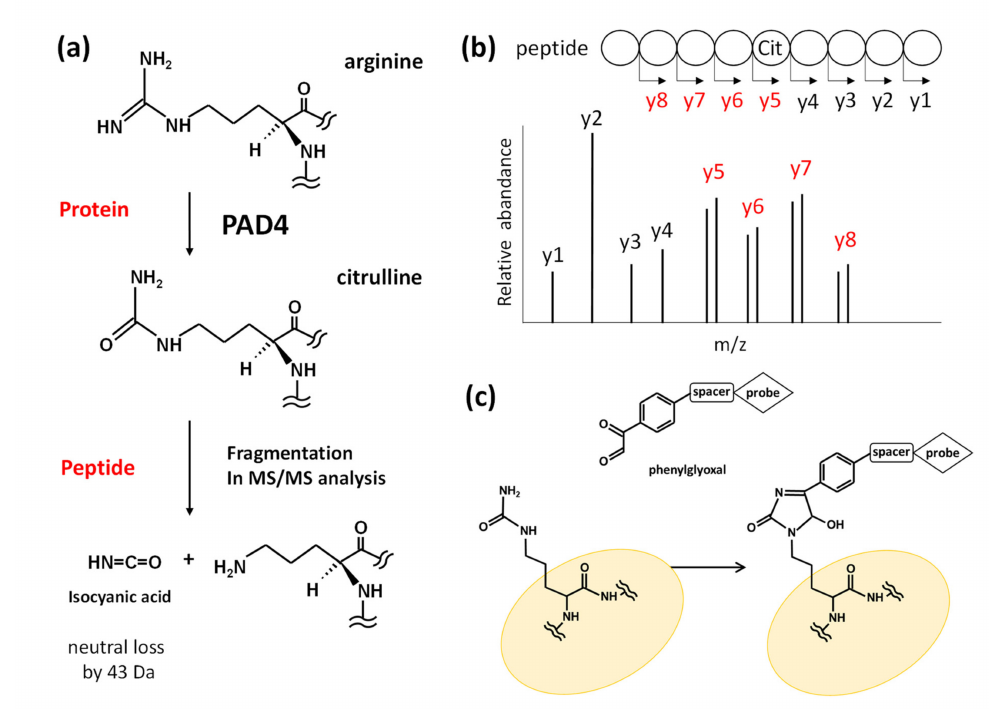
Figure 1. Structures of the citrulline residue and the methods to identify citrullinated proteins using tandem mass spectrometry (MS / MS). ( a ) Deimination of an arginine residue by peptidylarginine deiminase (PAD) 4 produces a citrulline residue. In MS / MS analysis, fragmentation of citrulline releases an isocyanic acid group that causes a 43 Da loss, which can be utilized in a neutral loss scan to detect citrulline residues. ( b ) MS / MS spectra of citrullinated peptides by neutral loss scan can determine the amino acid sequences and positions of citrulline residues. In the secondary MS stage, fragmentation of the peptide occurs at any peptide bond in addition to neutral loss of citrulline residue. The m / z signals correspond to fragments with di ff erent numbers of amino acid residues; the fragment ions containing citrulline can be identified as paired spectra with a 43 Da di ff erence. ( c ) Phenylglyoxal probes readily react with citrulline residues to form stable adducts under acidic conditions. These probes contain the structural moiety of rhodamine or biotin to assist specific detection or